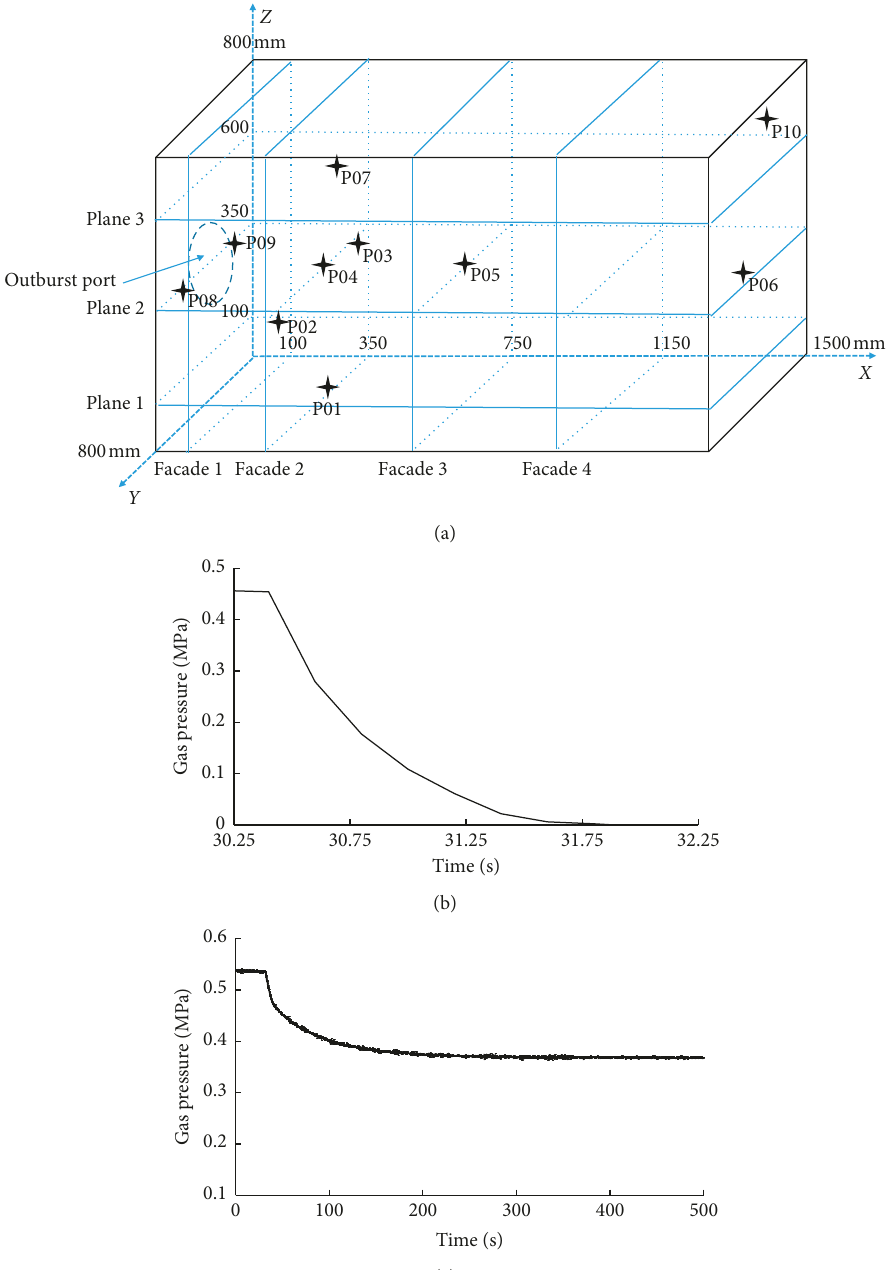
Figure 5: Variation characteristics of gas pressure during coal and gas outburst. (a) Arrangement of gas pressure sensors. (b) Sensor P09. (c) Sensor